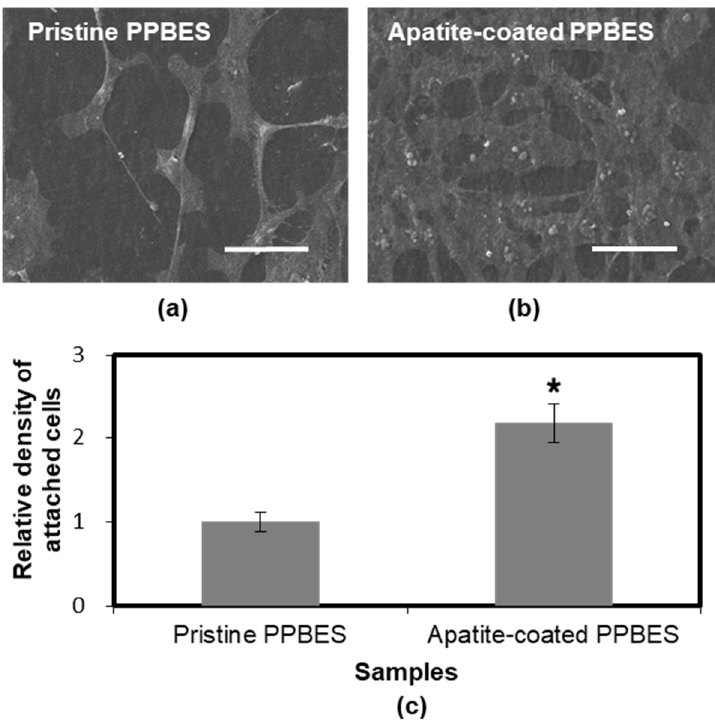
Figure 8. SEM images of NIH-3T3 cells cultured for 48 h on pristine PPBES ( a ) and apatite-coated PPBES ( b ) (scale bar = 50 µm). ( c ) Relative cell-adhesion density of NIH-3T3 cells cultured for 48 h on pristine PPBES and apatite-coated PPBES. * p < 0.05 relative to pristine PPBES.